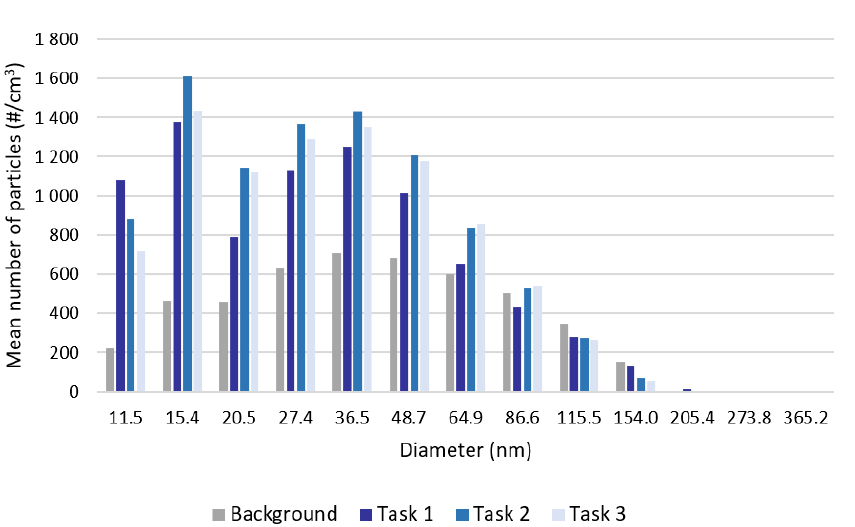
Figure 2. Results provided by the SMPS: Mean particle number concentration (particles/cm 3 ) by particle size range.